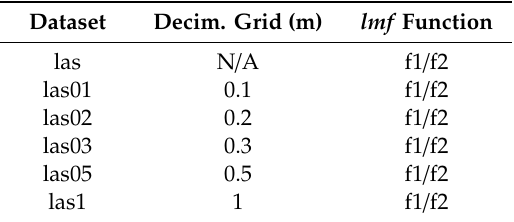
Table 5. Overview of the UAS PPC datasets and their parameters used for the creation of treetop seed points dataset, CHM rasterization and ITCD. The original PPC was used only for preliminary treetop seed points